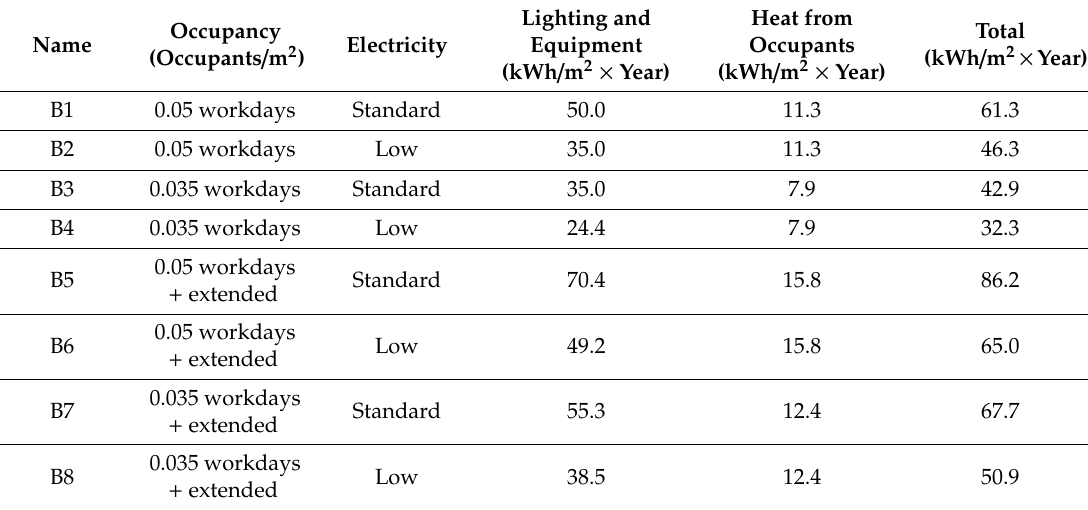
Table 3. Di ff erent values for internal heat gains used in the models. Lighting and equipment does not include the electricity use of the ventilation